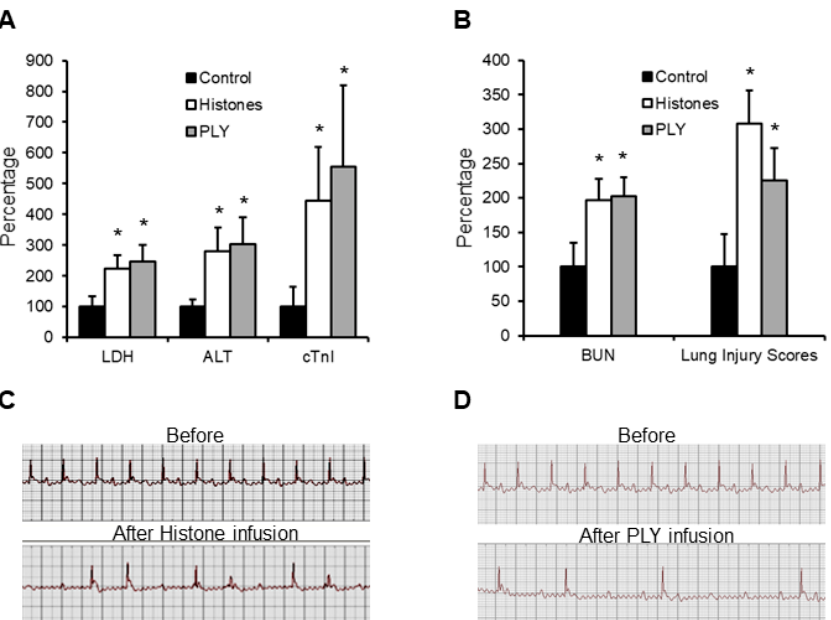
Figure 2. Calf thymus histones and PLY infusion mouse models. Five mice per group were infused with saline (control), calf thymus histones (50 mg/kg), or PLY (400 µg/kg) through tail veins. Blood was collected at 12 h and LDH, ALT, cTnI ( A ), as well as BUN and lung injury scores ( B ), were detected. The means ± SD of the relative increase to controls are presented. An ANOVA test * p < 0.05 was compared to the control. ECG was recorded before and within 4 h after histone ( C ) or PLY ( D ) infusion. Typical traces showing arrythmia are presented.